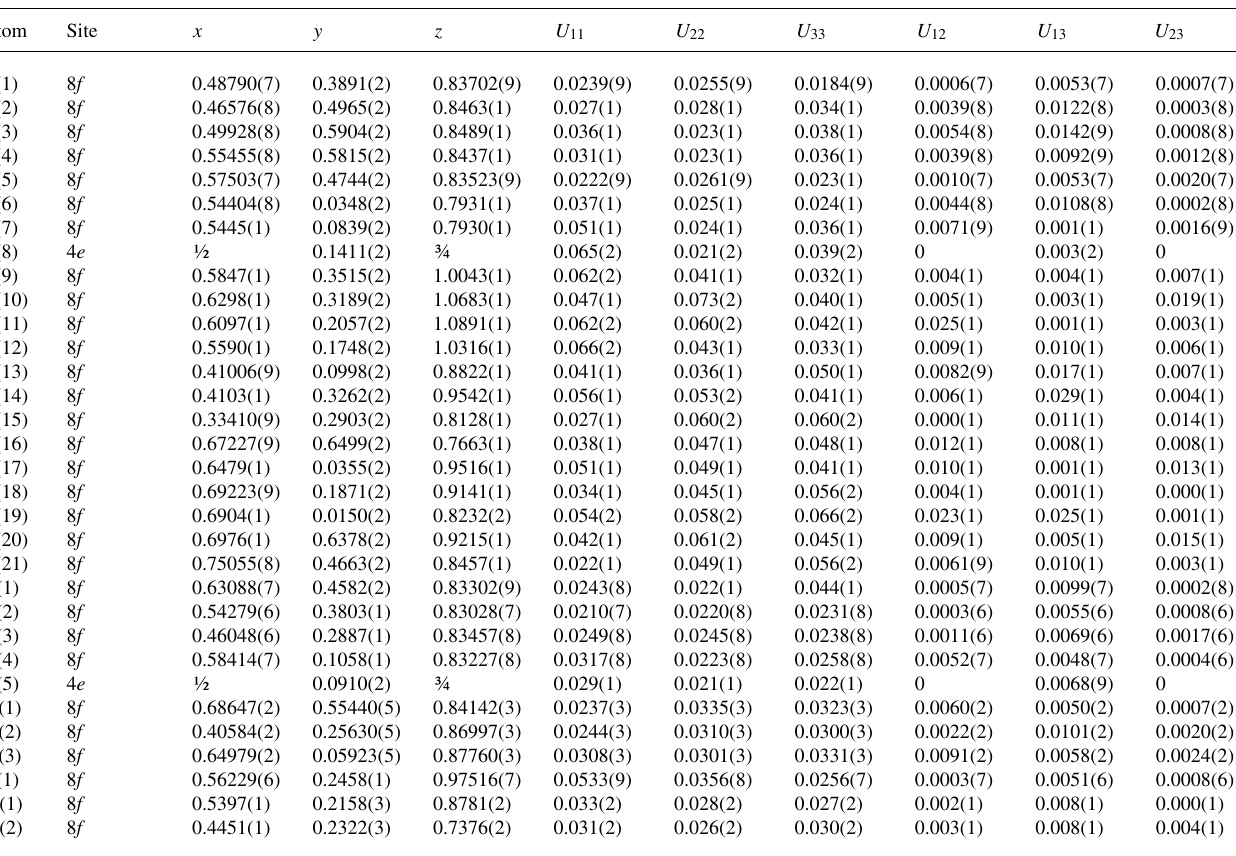
Table 3. Atomic coordinates and displacement parameters (in Å 2 )